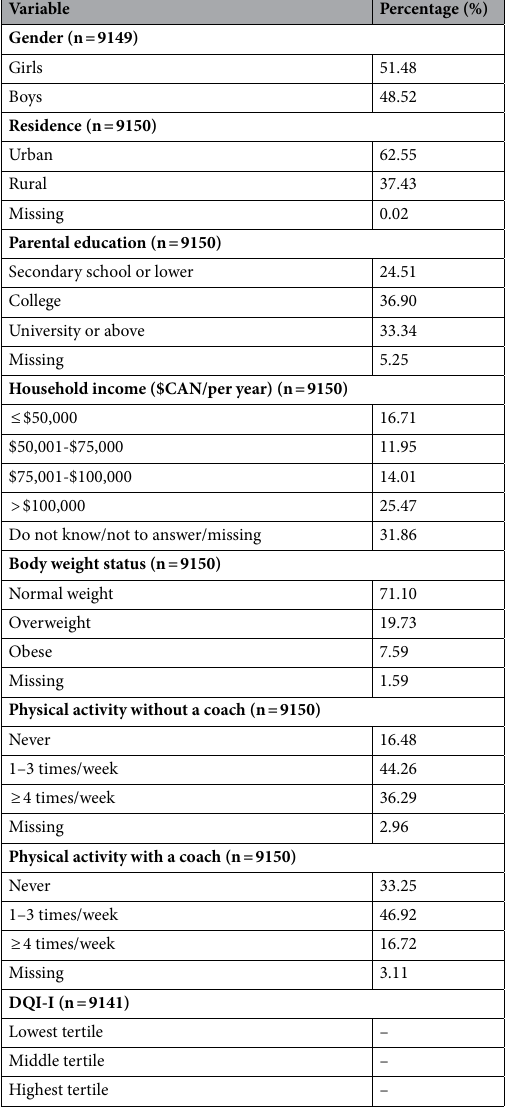
Table 1. Frequency distributions of socio-demographic characteristics, body weight, physical activity and diet quality among of grade five students participating in the 2008, 2010 and 2012 Real Kids Alberta surveys in